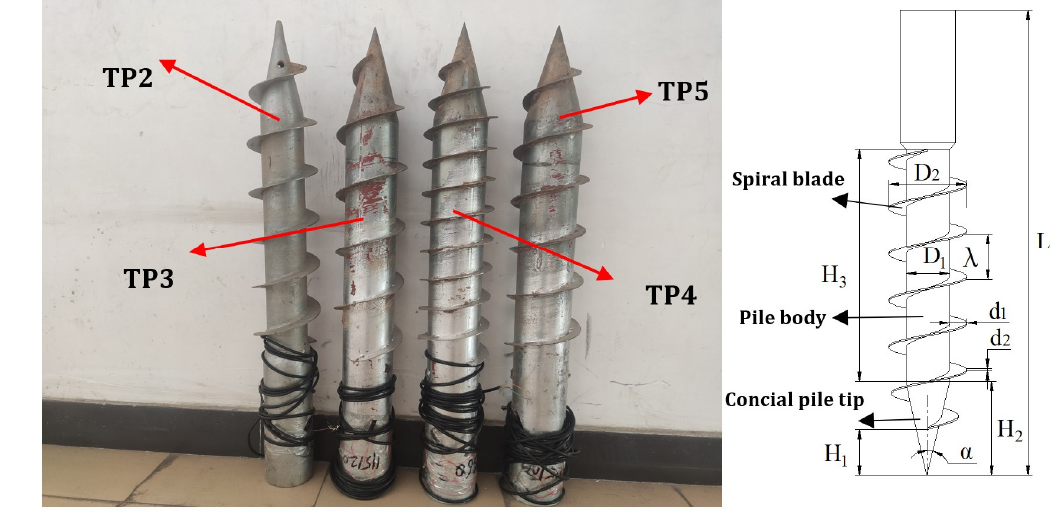
Figure 4. The test screw piles. Table 2. Structural parameters of the test screw piles.